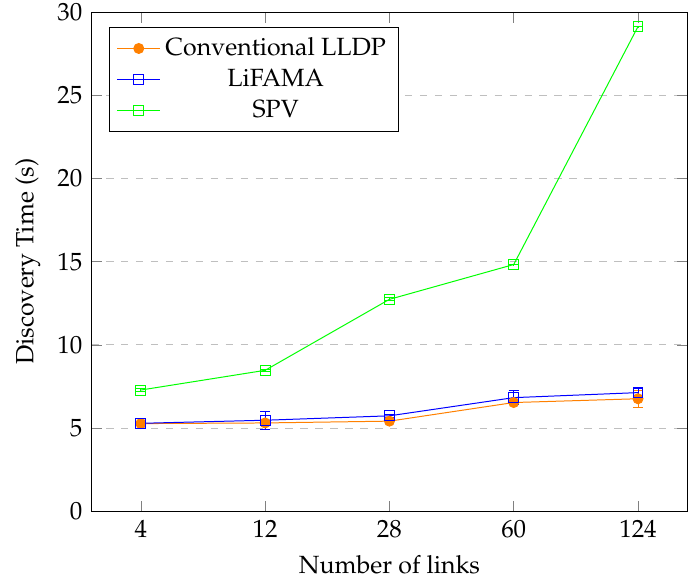
Figure 11. Tree topology performance.